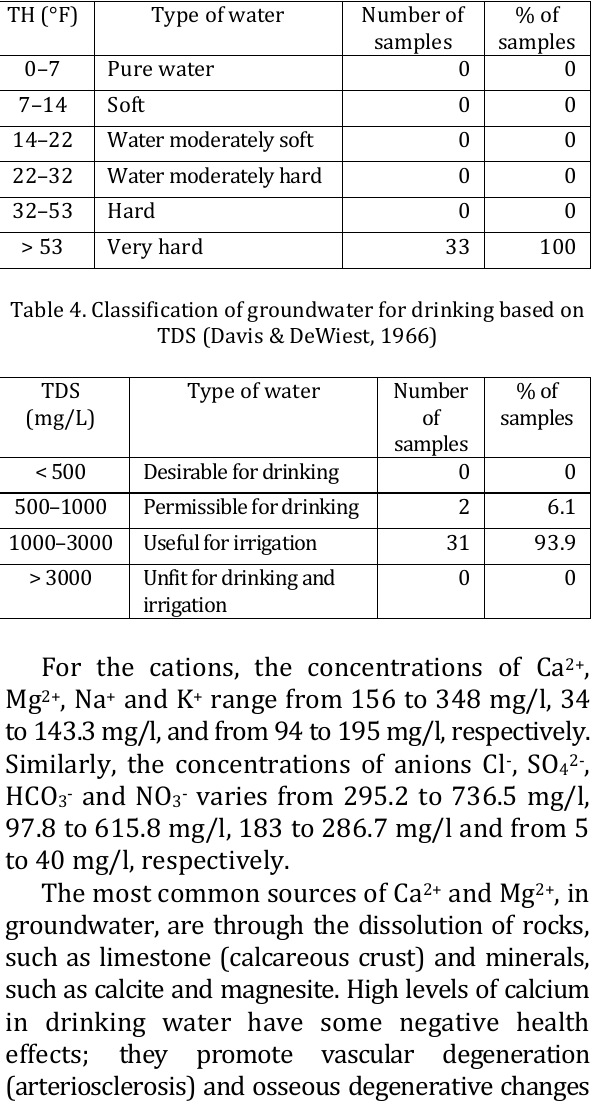
Table 3. Classification of groundwater for drinking based on